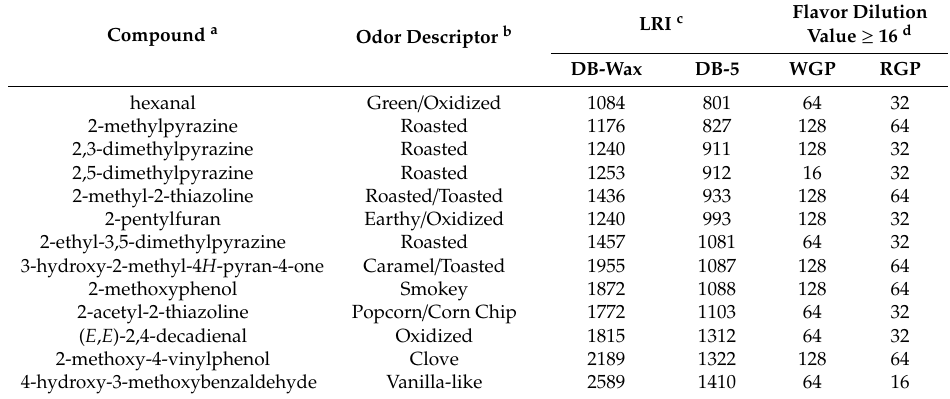
Table 1. Identified aroma compounds in extruded maize refined grain pu ff s (RGP) and whole grain pu ff s